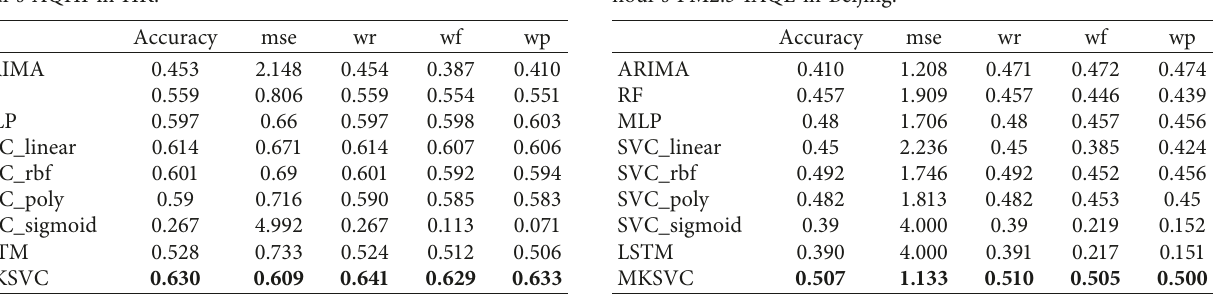
Table 11: Performance comparison for predicting the future 12 hour’s AQHI in HK.